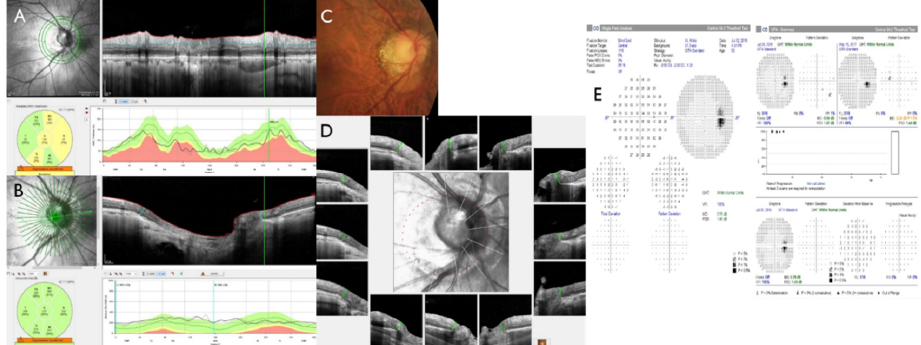
Figure 1. Representative case of a large optic disc. A 54-year-old male with disc area of 2.83 mm 2 (normal range: 1.63~2.43) and spherical equivalent of -4.88 Diopter showed abnormal classification at the superotemporal (ST) sector ( A ). However, Bruch’s membrane opening minimum rim width (BMO-MRW) showed normal classification at global and at six sectors ( B ). Fundus photography showed no focal neuroretinal rim thinning or notch with β-peripapillary atrophy (PPA) in a large disc ( C ). The BMO overview showed round BMO-based optic disc margin (dotted red line) including the PPA area ( D ). Note that the superior curve and peak of peripapillary retinal nerve fiber layer (RNFL) shifted to a more nasal position than normative data (A). This yielded abnormal classification of the ST sector of RNFL or, in this case, of a large disc. Glaucoma hemifield test of the visual field was shown within normal limits in four consecutive tests ( E ).